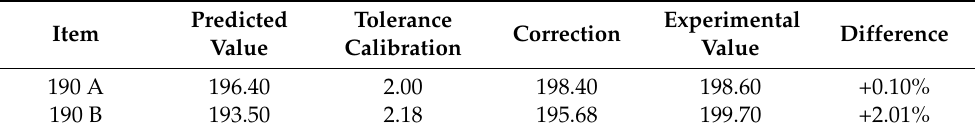
Table 8. Analysis of predicted and experimental